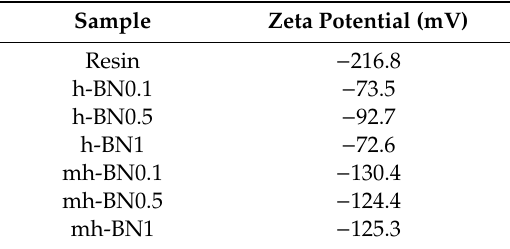
Table 2. Zeta potential results of the acrylic resin and the formulations with untreated (h-BN) and plasma-treated (mh-BN)